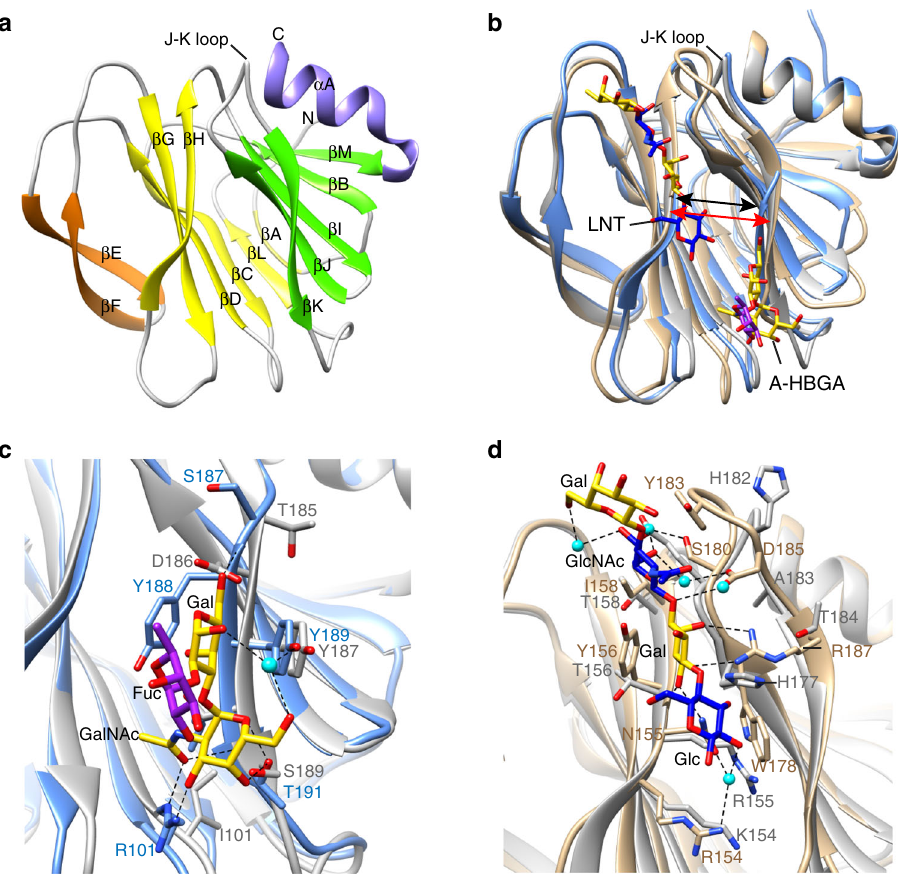
Fig. 2 VP8* structure of a neonatal human rotavirus strain P[6] RV3 and structural comparison with VP8*s of other HRVs in complex with HBGAs. a Ribbon representation of the P[6] RV3 VP8* structure displays a galectin-like fold with the two twisted β -sheets in yellow and green, respectively. The β -hairpin and the C-terminal α -helix and are colored in orange and purple, respectively. b Structural superposition of P[6] VP8* (gray) with HRV P[14] VP8* (light blue) in complex with A-type HBGA (PDB ID: 4DRV) and HRV P[11] VP8* (tan) in complex with LNT (PDB ID: 4YFZ). The width of the cleft between the β -sheets in P[6] and P[11] VP8*s is wider than that in P[14] VP8*, as indicated by red and black arrows, respectively. The glycans bound on VP8* are represented with sticks. Close-up views of the A-type HBGA ( c ) and LNT ( d ) binding sites show the amino acid changes in P[6] VP8* disallow the glycan binding at these sites. The interacting residues are shown in stick model and labeled. The proteins are colored as in